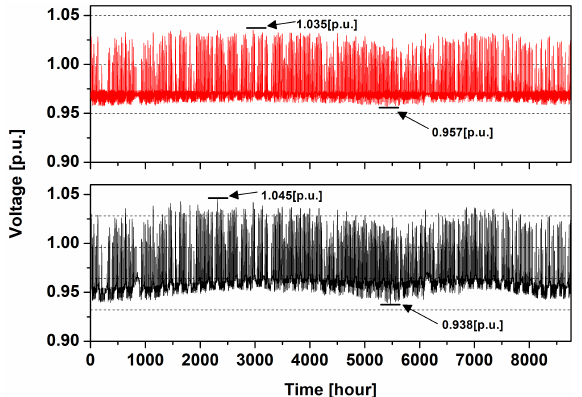
Figure 5. Voltage Profile when Volt–Var Function was applied or